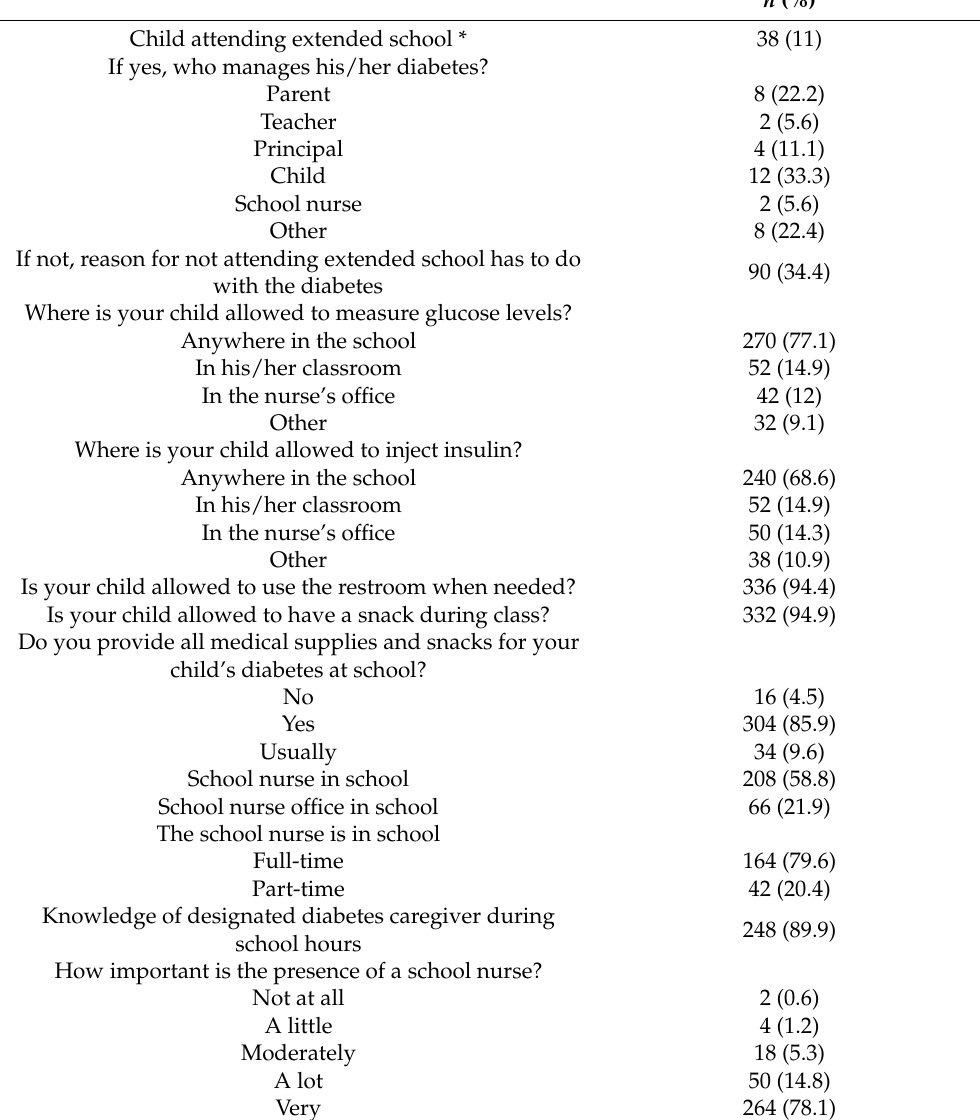
Table 2. Diabetic management in